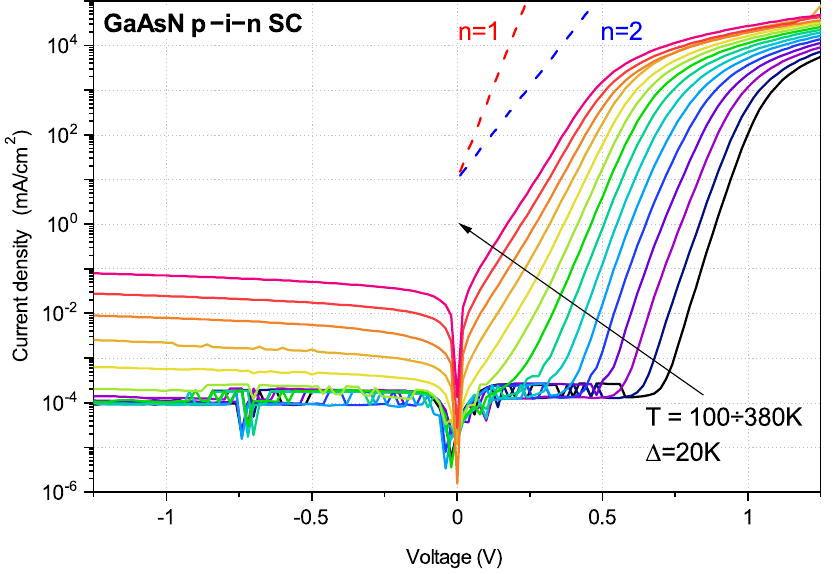
Figure 7. Temperature-dependent current-voltage characteristics of GaAsN p-i-n solar cell. Red and blue dashed lines represents the slope of diode with ideality factor of 1 and 2,